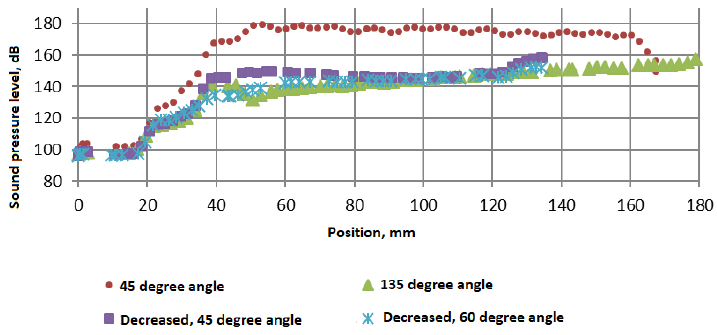
Figure 8. Comparison of sound pressure level in closed cavity